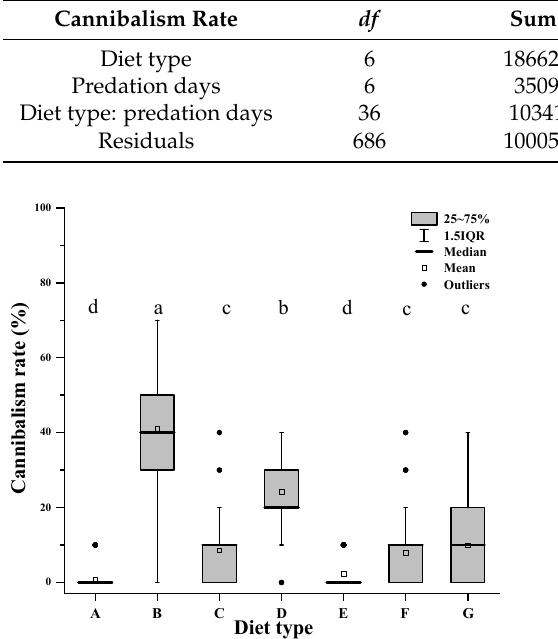
Table 3. ScheirerRayHare statistical test (Cannibalism rate – Diet type × Predation days) results of cannibalism rate in R.